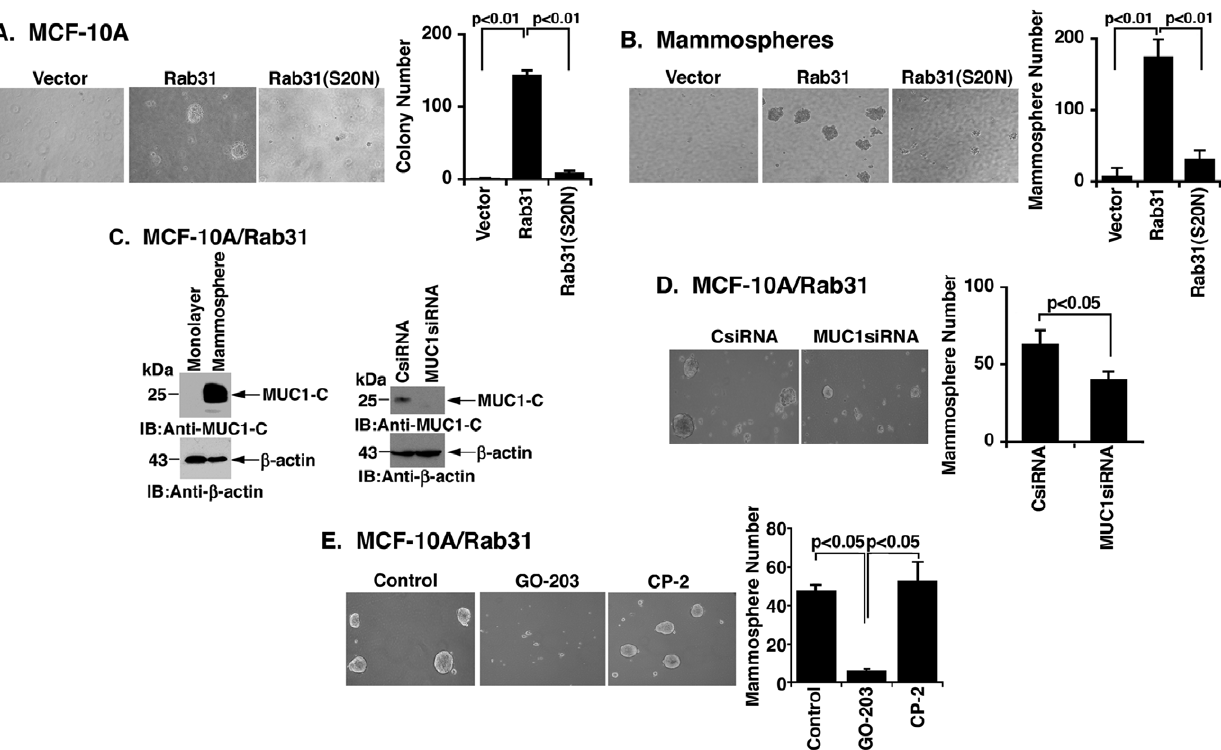
Figure 6. Rab31 promotes MCF-10A mammosphere formation by a MUC1-C-dependent mechanism. A. The indicated MCF-10A cells were seeded in soft agar. After culturing for 3 weeks, photomicrographs were obtained (left) and the numbers of colonies (mean 6 SD of three replicates) were determined by counting clusters of . 20 cells. B. The indicated MCF-10A cells were seeded under conditions for the growth of mammospheres. After culturing for 3 weeks, photomicrographs were obtained (left) and the numbers of mammospheres (mean 6 SD of three replicates) were determined by counting spheres of . 20 cells (right). C. Lysates from MCF-10A/Rab31 cells grown as an adherent monolayer and as mammospheres were immunoblotted with the indicated antibodies (left). MCF-10A/Rab31 cells were transfected with control and MUC1 siRNAs. Lysates were immunoblotted with the indicated antibodies (right). D. MCF-10A/Rab31 cells transfected with the indicated siRNAs were cultured for the growth of mammospheres. After 3 weeks, photomicrographs were obtained (left) and the numbers of mammospheres (mean 6 SD of three replicates) were determined by counting spheres of . 20 cells (right). E. MCF-10A/Rab31 cells were cultured for the growth of mammospheres in the absence (Control) and presence of 5 m M GO-203 or CP-2. After 3 weeks, photomicrographs were obtained (left) and the numbers of mammospheres (mean 6 SD of three replicates) were determined by counting spheres of . 20 cells (right).